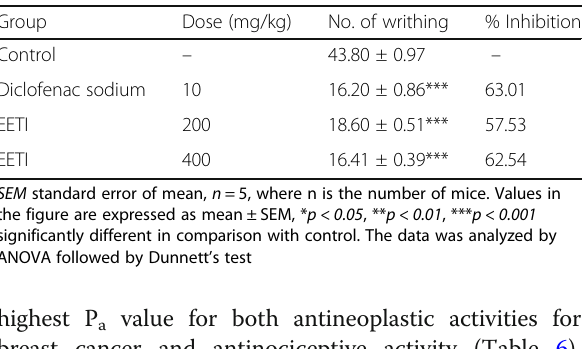
Table 3 Effect of EETI on acetic acid induced writhing